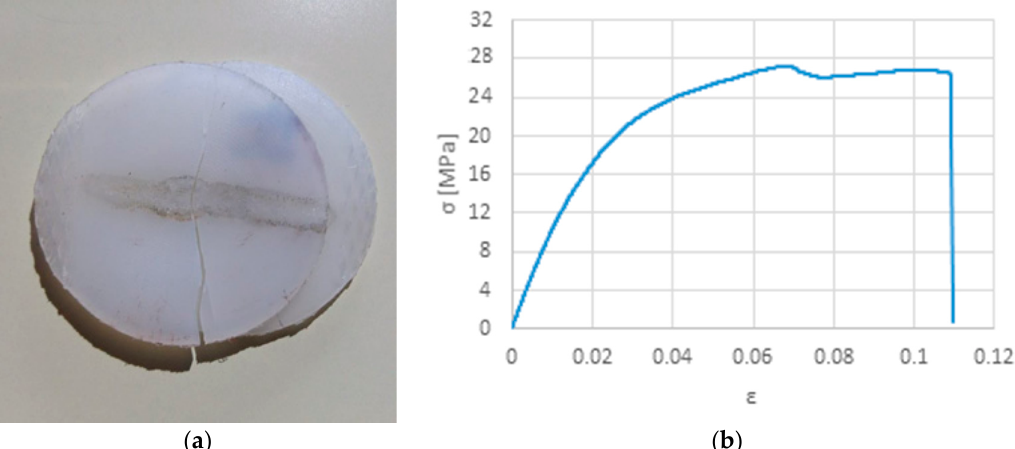
Figure 7. Results obtained with set 9: ( a ) Sample after testing exhibiting a fracture perpendicular to the joint; ( b ) Tensile stress-strain curve.